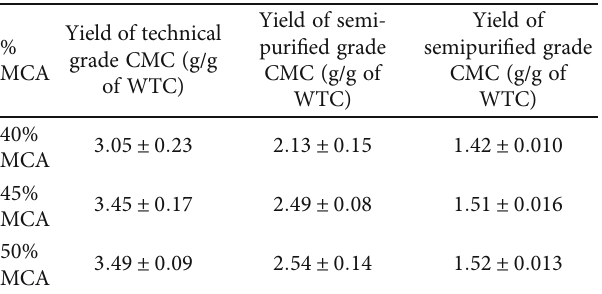
Table 1: Yield, purity, NaCl, moisture, and gel contents of di ff erent grades of CMC.